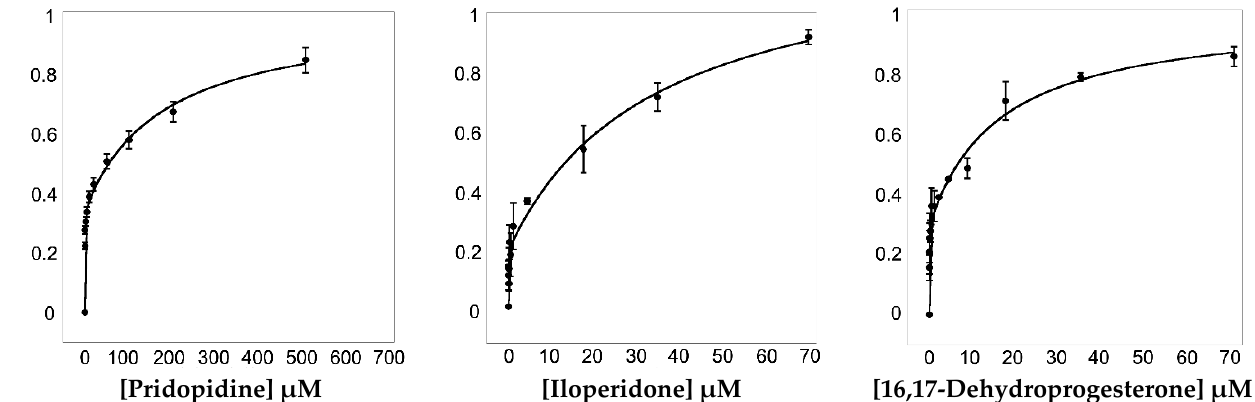
Figure 6. Titration of Hs σ1 -R with pridopidine ( left panel), iloperidone ( central panel) and 16,17- didehydroprogesterone ( right panel). ΔF/ΔF max values at 340 nm are plotted as a function of ligand concentration (see Materials and Methods section). Fluorescence titration analyses were performed using Equation (2) that describes a two-site model in which both sites are independent of each other and non-cooperative. Data are from three replicate experiments. Error bars are standard deviations (SD) with n = 3.